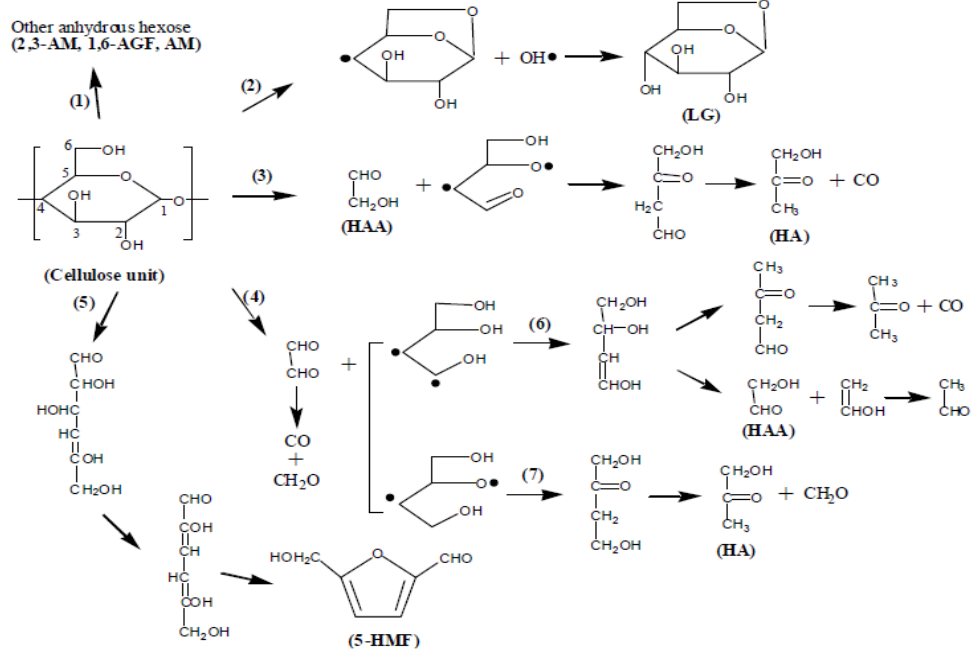
Figure 10. The speculative chemical pathways for the direct conversion of the cellulose molecules.